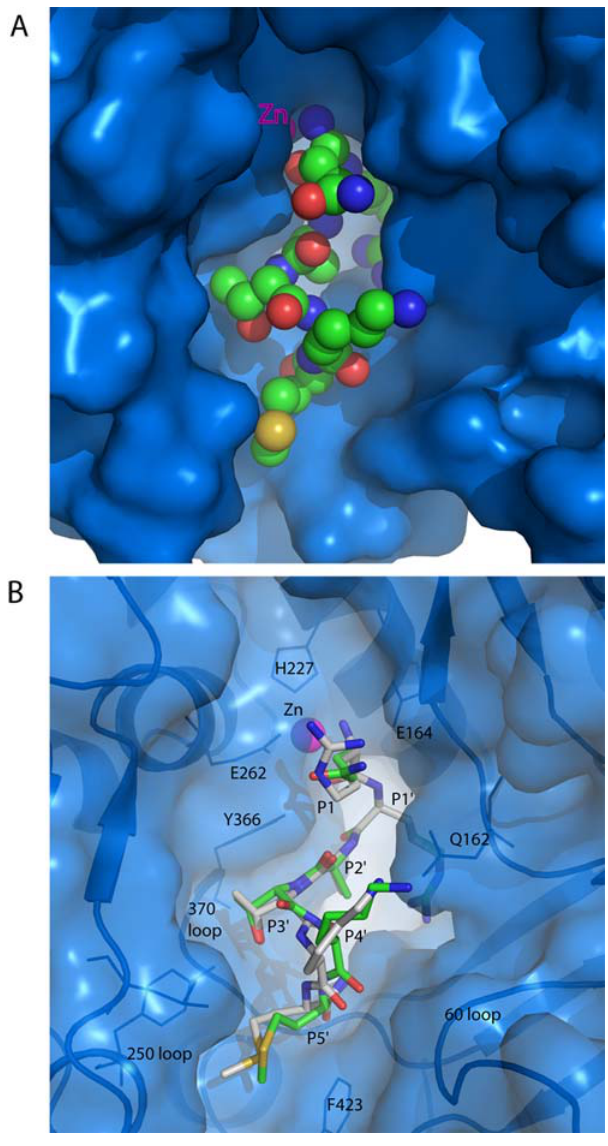
Figure 2. Binding of the substrate peptide in the active site of Balc424. (A) Figure shows the substrate peptide (QRATKM) binding in the active site of Balc424. Balc424 is shown in solid blue-colored surface. Substrate peptide is shown in sphere (CPK) model. Carbon, oxygen, nitrogen, sulfur and zinc atoms are shown in green, red, blue, yellow and magenta, respectively. (B). Superposed stick models of QRATKM and RRATKM are shown in green, and gray, respectively. Carbon atoms are shown in green (QRATKM) and gray (RRATKM). Balc424 is shown in semi-transparent surface (blue) representation with secondary elements at the active site pocket. Only a few substrate-binding residues are shown as markers. Pymol (DeLano, W.L. The PyMOL Molecular Graphics System (2002) on World Wide Web http://www.pymol.org) was used to prepare these figures.